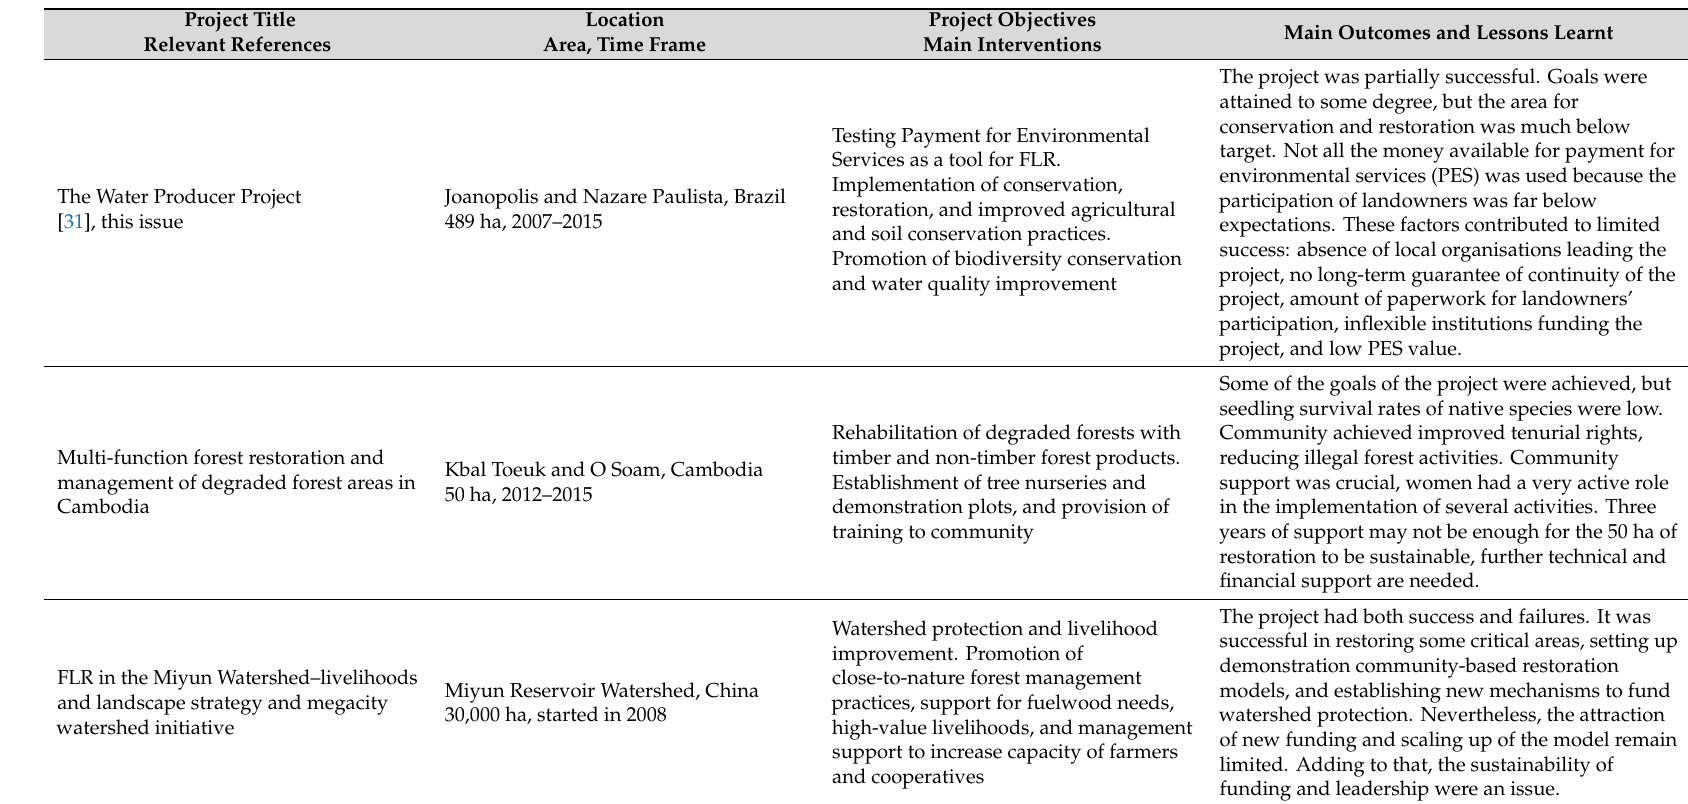
Table 1. Details of forest and landscape restoration case studies presented in the International Conference on Forest and Landscape Restoration (FLR) held in Manila, Philippines in February 2019. All presentations are available at https: // flr2019.weebly.com /